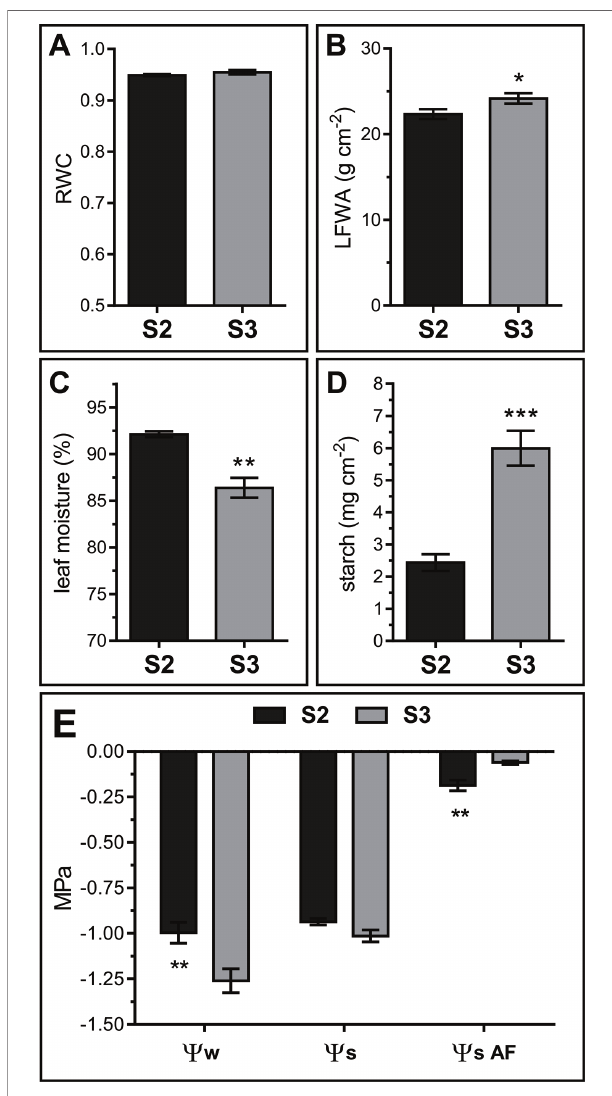
FIGURE 2 | Water relations in S2 and S3 leaves. (A) Relative water content (RWC). ( B ) Leaf fresh weight per unit of leaf area (LFWA). (C) Leaf water content (LWC), expressed as percentage of water per leaf FW. (D) Starch content expressed as mg of glucose per unit leaf area. (E) Leaf water potential ( Y w ) measured on leaf disks, solute potential of freeze-thaw squeezed leaves ( Y s ) and AF solute potential ( Y S AF ). Data represents the average of biological samples (n). (A) RWC: n = 6 (S2) and n = 6 (S3), (B) LFWA: n = 11 (S2) and n = 13 (S3), (C) LWC: n = 6 (S2) and n = 6 (S3), (D) starch: n = 5 (S2) and n = 6 (S3), (E) Y w : n = 13 (S2) and n = 13 (S3), Y s : n = 4 (S2) and n = 6 (S3), Y S AF : n = 4 (S2) and n = 4 (S3). Values were normally distributed and signi fi cant differences were calculated between S2 and S3 at P ≤ 0.05 using the Student's t test: *, P < 0.05; **, P < 0.01; ***, P < 0.001. Values in the graphs show the average ±